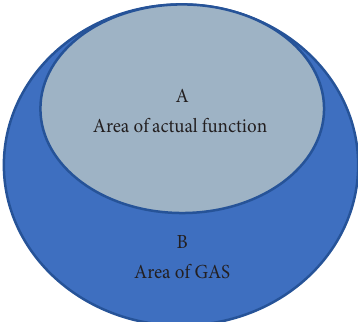
Figure 6: Schematic of the identification index. Table 7: Results of quantitative